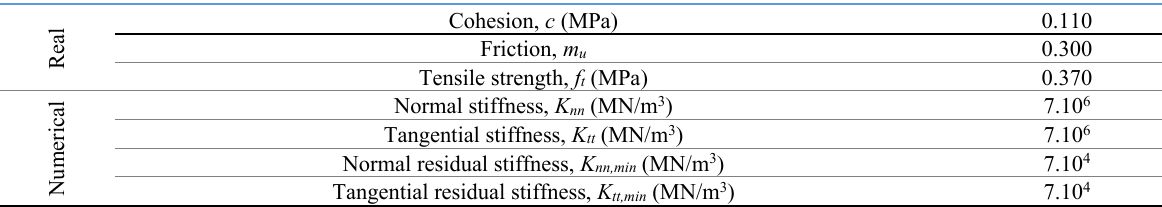
Table 5. Interface constitutive parameters.